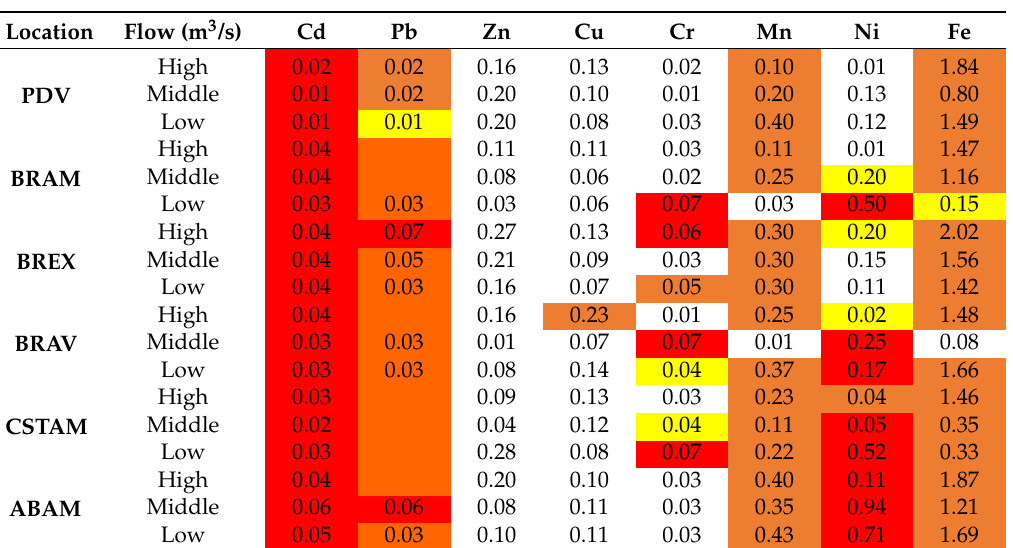
Table 3. Metal quality classes (mean analytical results expressed in mg/L) as a function of the flow levels of the Chari River for each